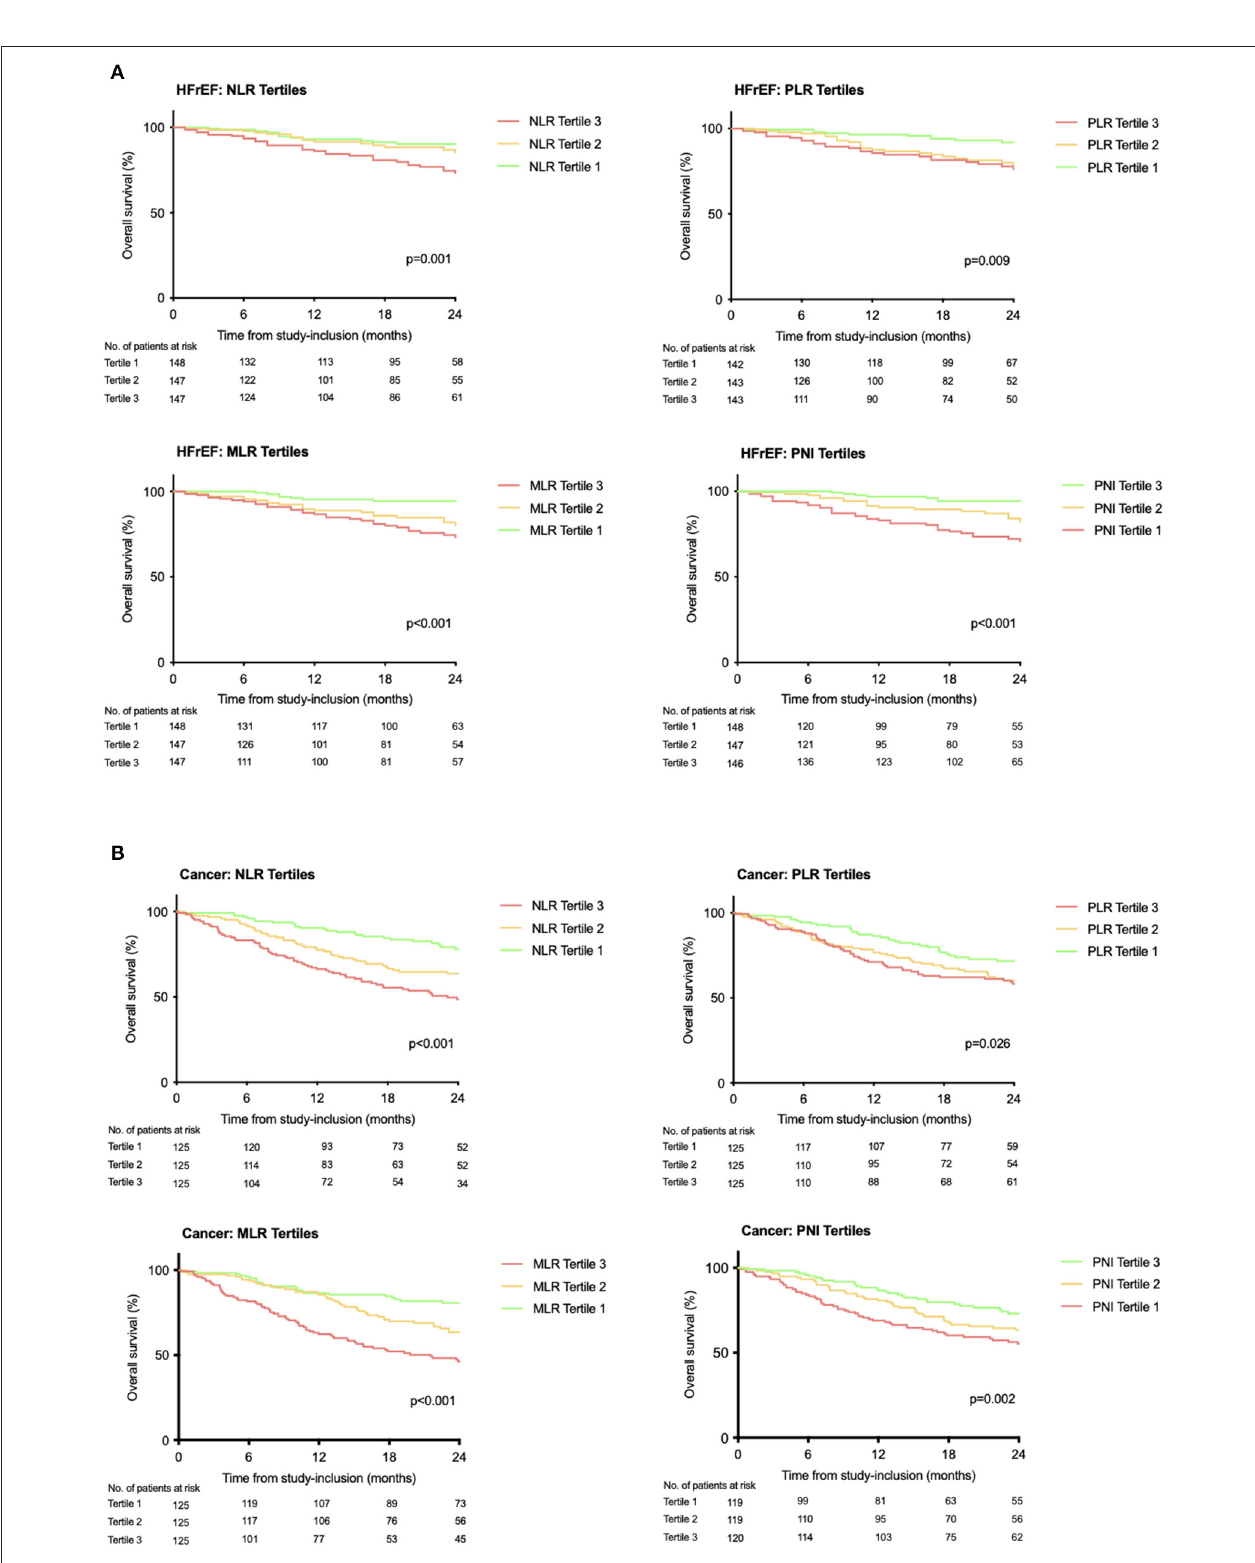
FIGURE 3 | Kaplan–Meier estimates for overall survival in stable HFrEF (A) or treatment naïve cancer (B) according to prognostic scores. Assessed for within-population tertile strata. Curves were compared by the log-rank test.